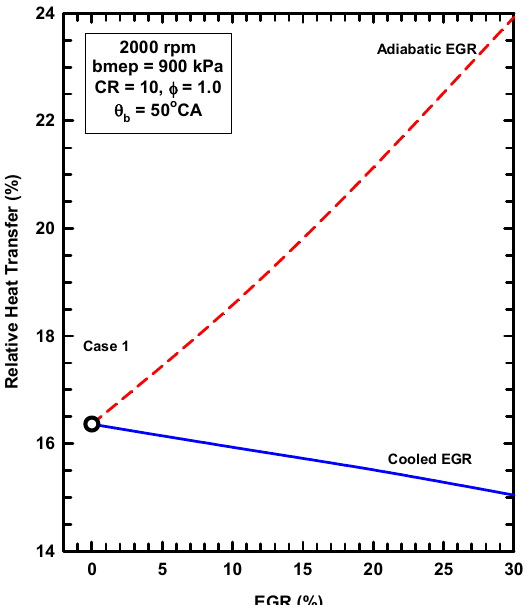
Figure 14. Relative heat transfer as functions of the EGR percentage for the two EGR configurations.